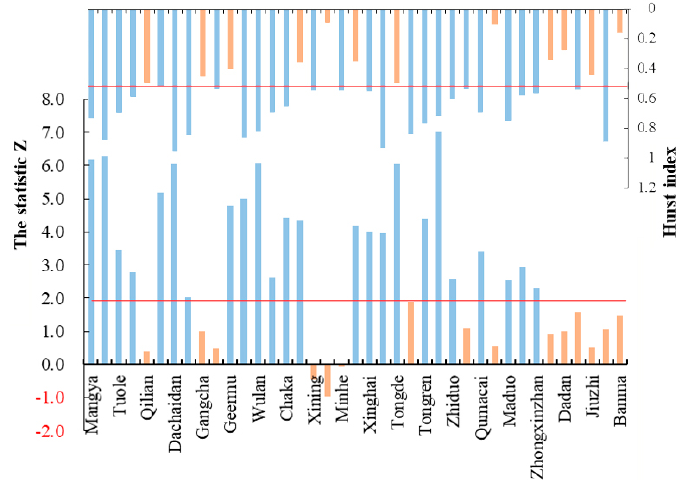
Figure 7. The Z value and Hurst index of NDVI series for 39 meteorological stations in Qinghai Province.